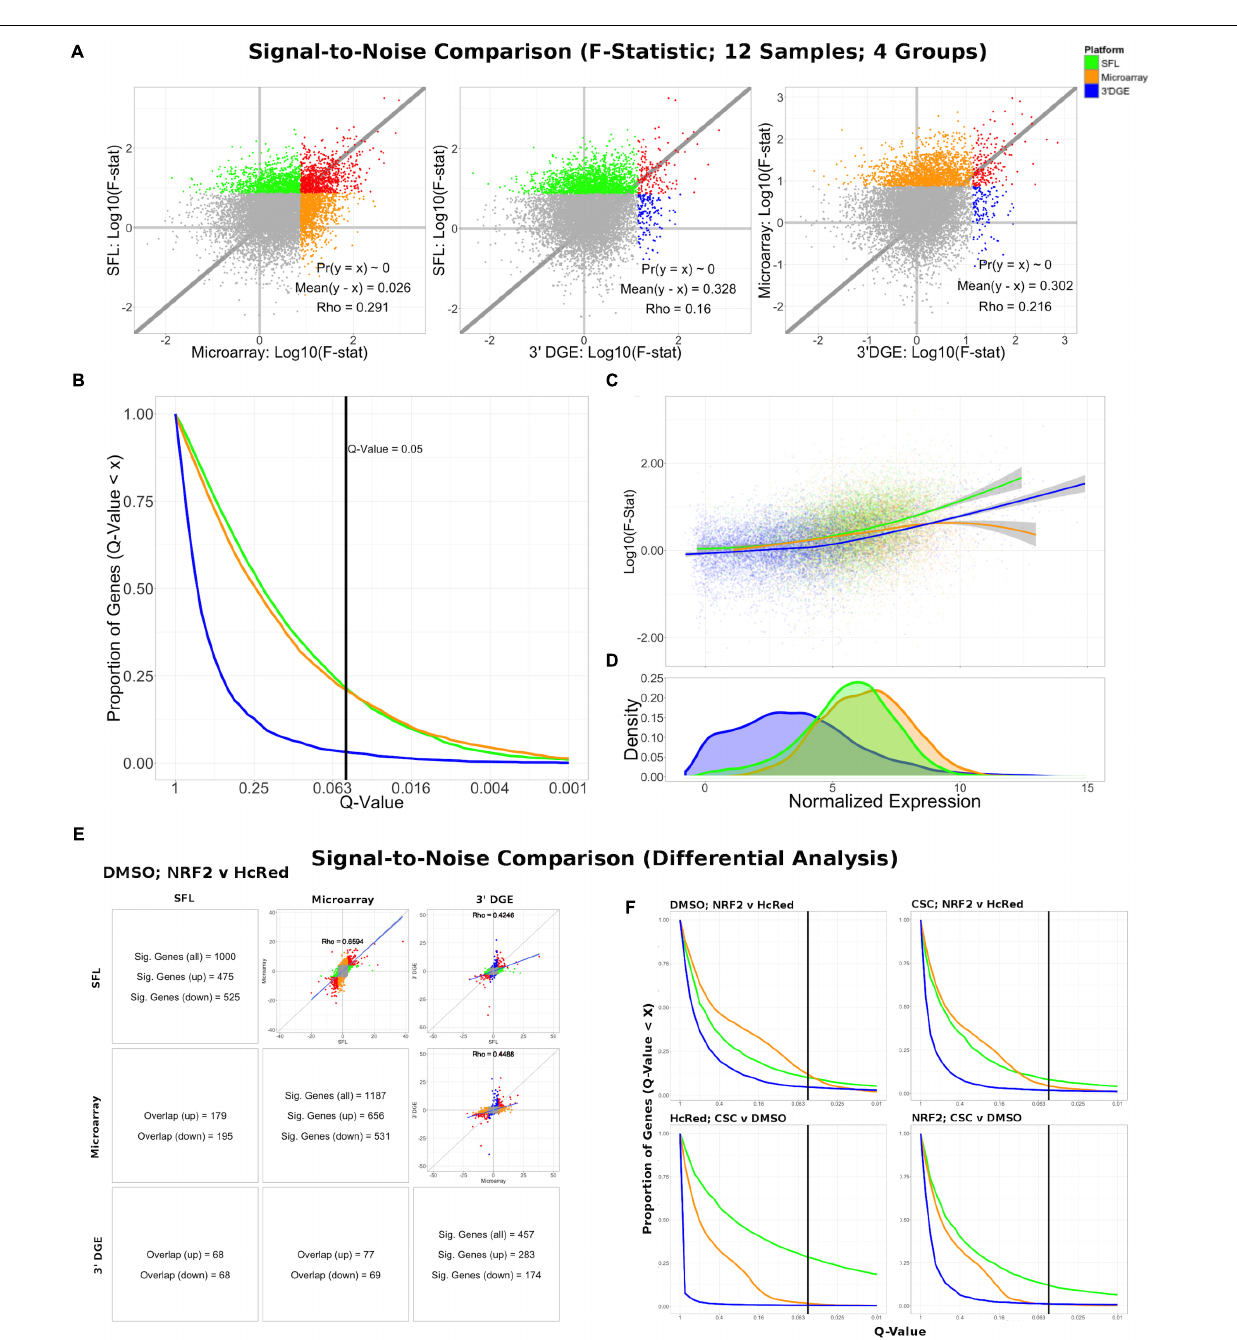
FIGURE 3 | Signal-to-noise comparison between SFL, microarray, and 3 (cid:48) DGE. (A) Scatterplots comparing the log10( F -Statistics) from ANOVA models comparing four n = 3 groups (HcRed:DMSO, HcRed:CSC, NRF2:DMSO, and NRF2:CSC). The gray line shows y = x . The platform with the higher mean log10( F -Statistic) is plotted on the y -axis. Also, included are the p -value and difference in mean between each bi-platform comparison from paired t -testing, as well as the squared correlation coefficient. P -values ∼ 0 are less than 0.01. Color of indicate genes discovered by individual platforms (green, orange, or blue), neither platform (gray), and both platforms (red). (B) Plot of the Discovery Rate versus FDR Q -Value from threshold for each platform from four group ANOVA models. The x -axis is plotted on a –log10 scale. The vertical line is indicative of a Q -value threshold of 0.05. (C) Loess fit of the log10( F -Statistic) versus median normalized expression from four group ANOVA models. (D) Distribution of mean normalized expression across all three platforms. (E) Comparison of gene discovery (FDR Q -Value < 0.05) by differential analysis with limma, comparing normalized gene expression between DMSO:NRF2 and DMSO:HcRed, including the raw discovery rates, discovered gene overlap, and linear fits, comparing test statistics from each platform. Genes that are discovered by more than 1 platform are shown in red in the scatterplots. Additional comparisons are shown in Supplementary Figure S5 . (F) Plot of the Discovery Rate versus FDR Q -Value from threshold for each platform from two group differential analyses. The x -axis is plotted on a –Log10 scale. The vertical line is indicative of a Q -value threshold of 0.05.